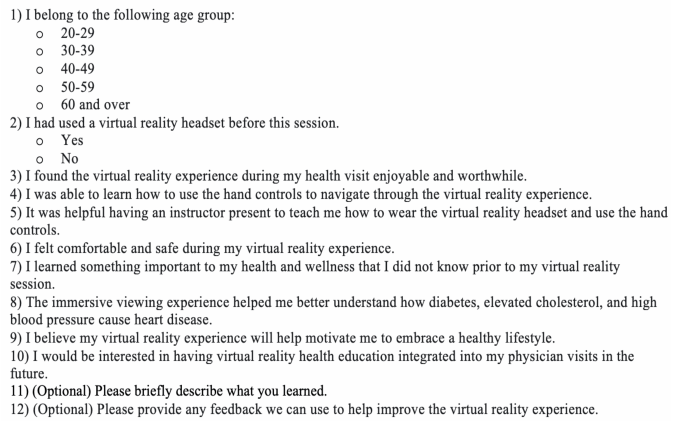
Fig. 5. VR survey (for questions 3–10, response options include: (5) strongly agree, (4) agree, (3) neutral, (2) disagree, and (1) strongly